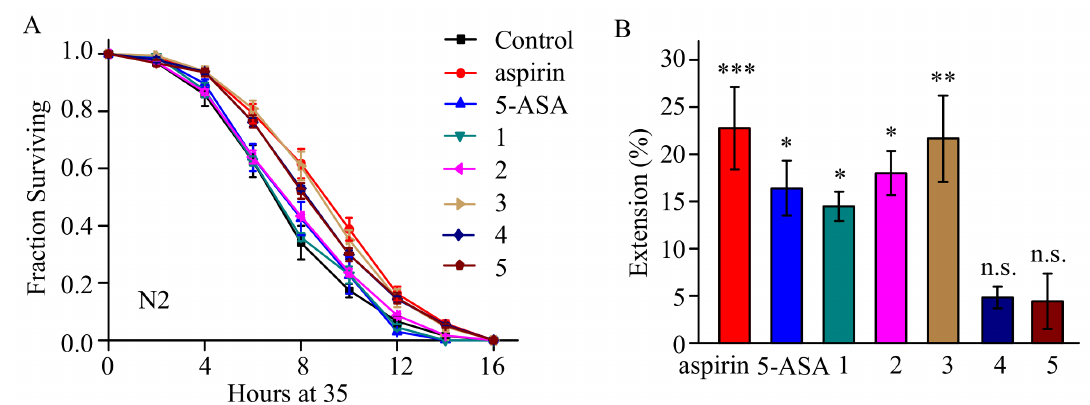
Figure 2. The thermotolerance activity of the analogues of aspirin. ( A ) Figures showed the survival rate of control and worms treated with different compounds in thermotolerance in 35 ◦ C. Error bars represent mean ± SEM; ( B ) Extension was shown in mean value of three independent experiments, and error bars represent SEM. * p < 0.05, ** p < 0.01, and *** p < 0.001; n.s. is not significant. At least 40 worms were used in each group, and three biological repetitions were performed in every